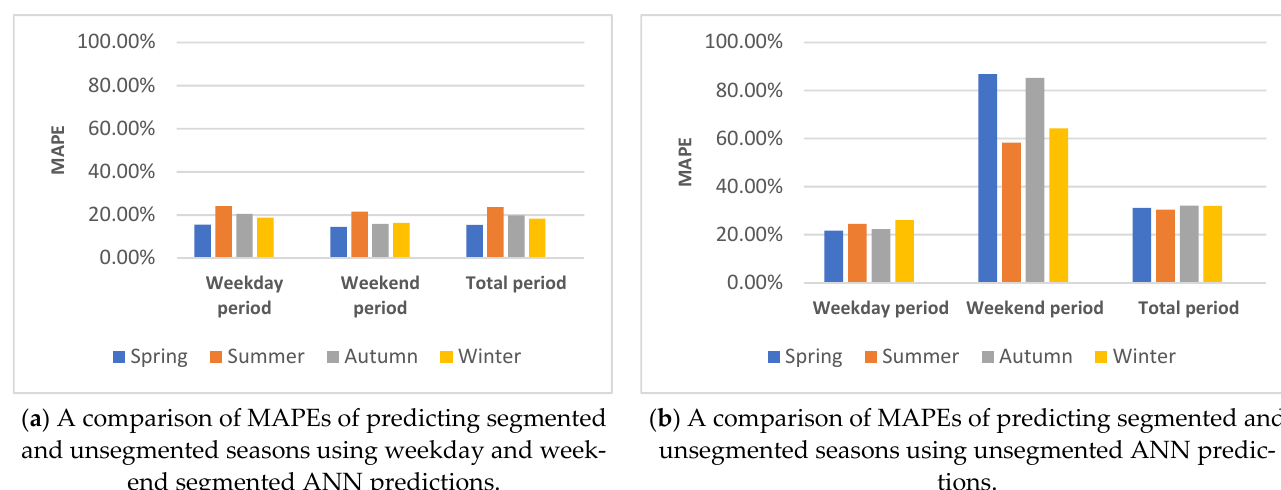
( b ) A comparison of MAPEs of predicting segmented and unsegmented seasons using unsegmented ANN predic- tions. Figure 14. A comparison of weekday and weekend segmented and non-segmented ANN prediction’s MAPEs.